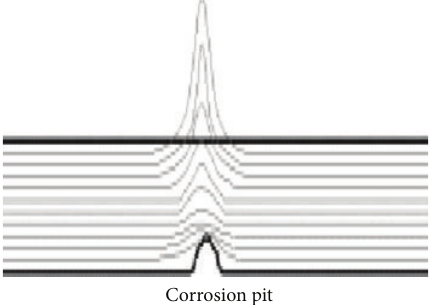
Figure2:Cross-sectionalareaofthesamplewithfulloflineoffluxes and company of corrosion